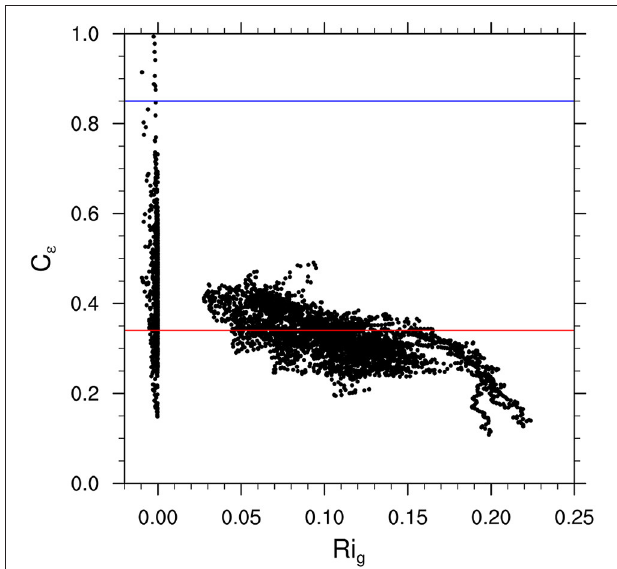
FIGURE 4 | TKE dissipation constant C ǫ computed by Equation (1) as a function of the gradient Richardson number (Equation 13) from neutrally stratified (N10 and N20) and stably stratified (S8C25, S8C50, S8C100, S5C135, S6C25, and S10C25; see Table 1 ) LESs. Horizontal lines represent the current constant value of C ǫ 0.85 (blue) and the new value of C ǫ 0.34 = = (red) estimated as the mean of all